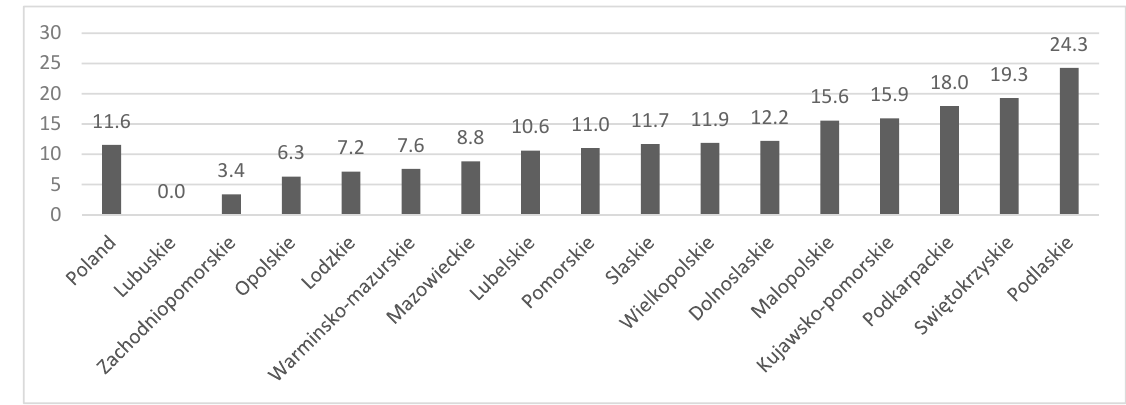
Figure 1. Geographical distribution of patients with pulmonary arterial hypertension (PAH). The mean prevalence of PAH per million children in different Polish voivodeships.